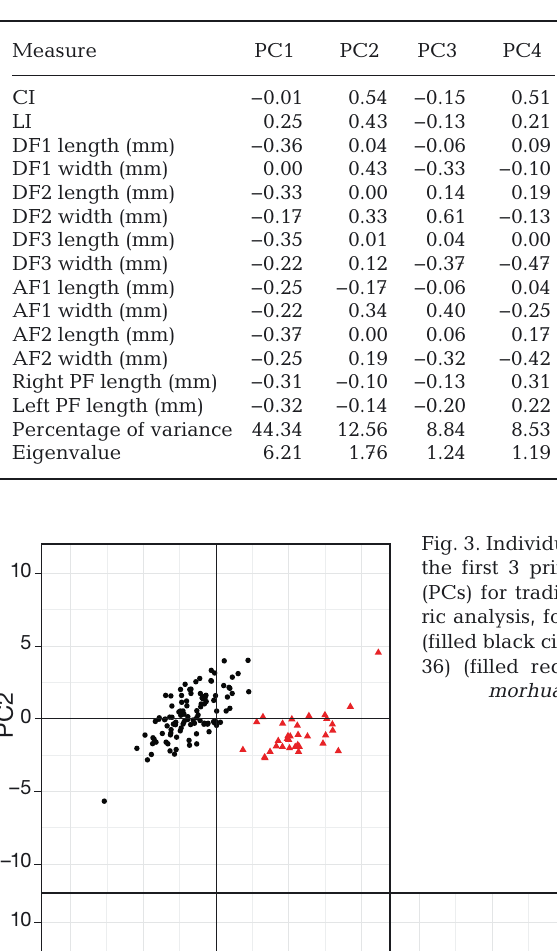
Table 2. Percentage of explained variance, eigenvalues, and the loadings of the measurements included in the principal component analysis (PCA) (with varimax rotation) on the first 4 principal components (PCs), for farmed and wild Gadus morhua . DF, AF, and PF refer to the dorsal, anal, and pelvic fins respectively, and their corresponding numbering begins with the most anterior fin. Condition index (CI) and liver index (LI) are the standardized residuals of the regres- sion of standard length, and liver weight on total weight re- spectively. Fin sizes were standardized to a common cen- troid size, while the calculation of CI and LI includes an inherent